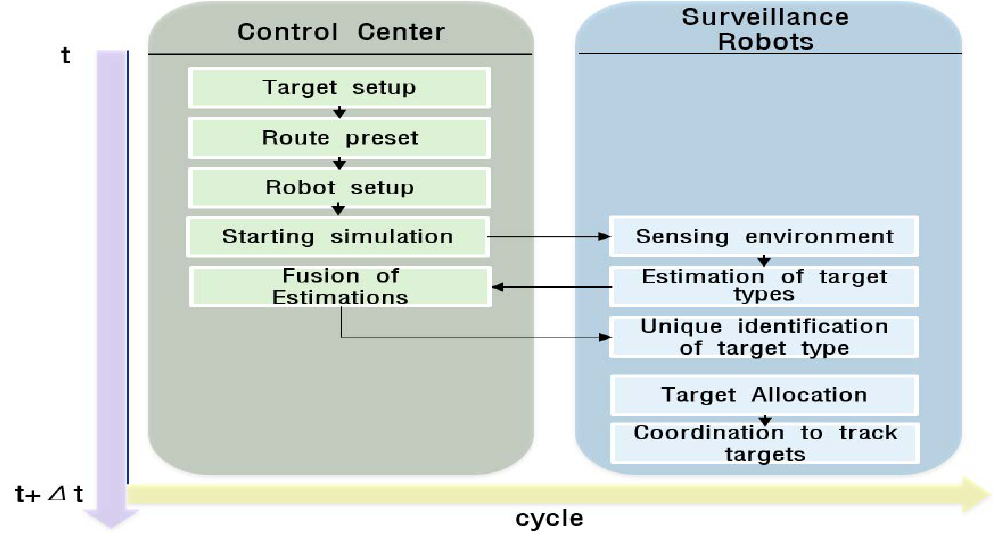
Figure 2. Event flow of the integrated intelligent fusion